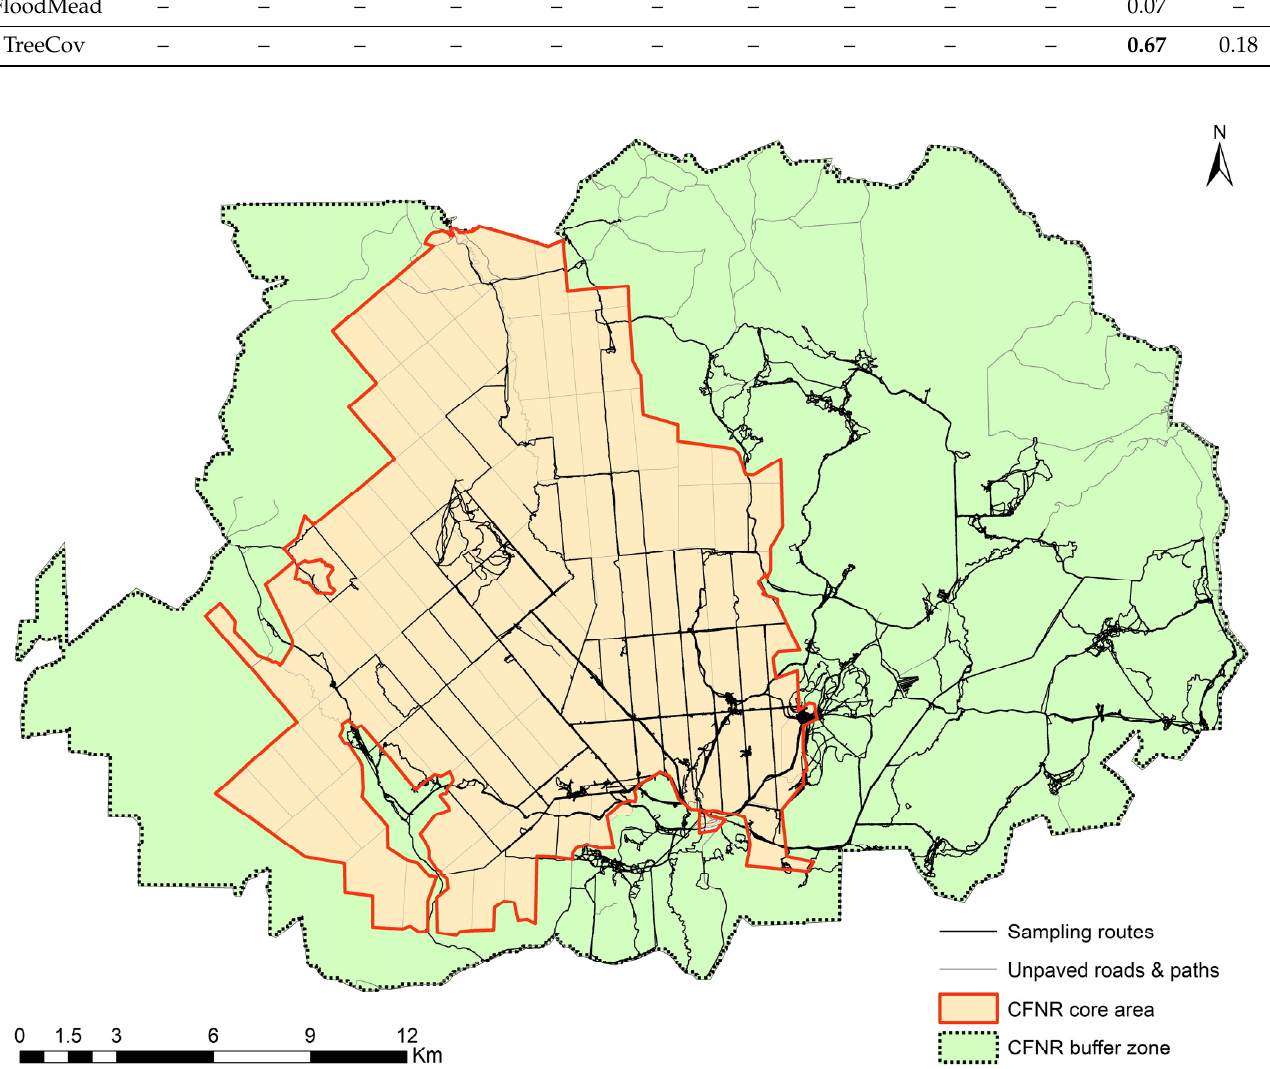
Figure A1. Sampling routes on the distribution of brown bear food resources in the territory of the